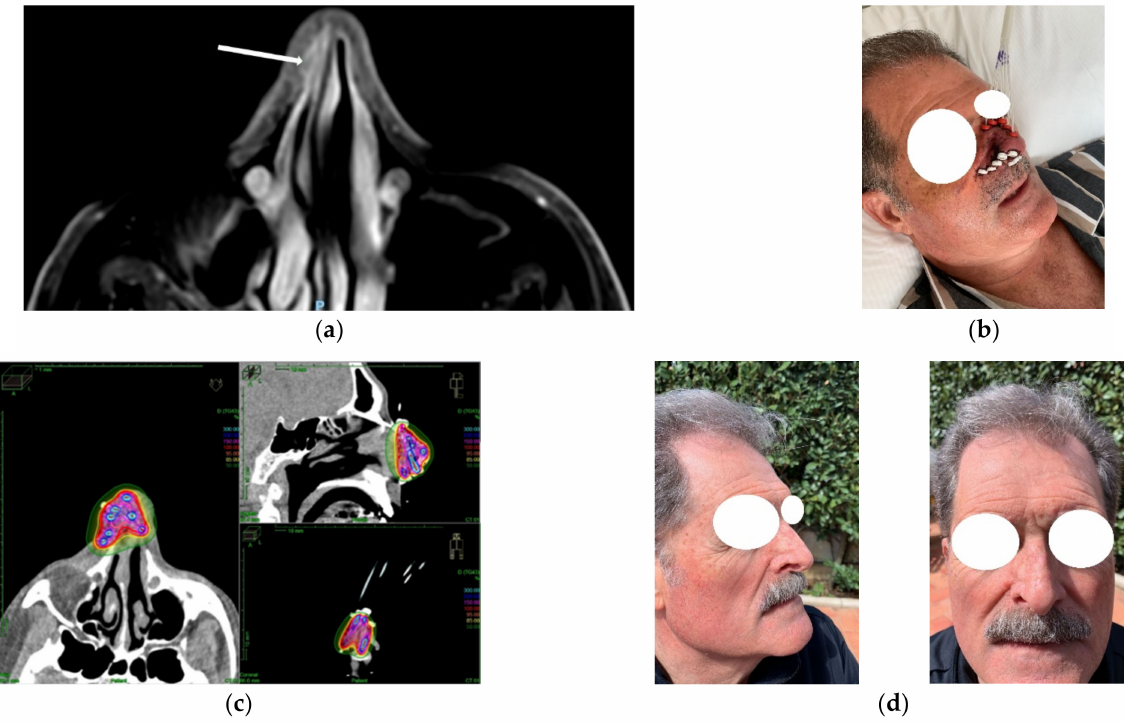
Figure 3. ( a ) MRI with initial diagnosis. ( b ) Implant with plastic tubes and buttons sutured to the skin. ( c ) Treatment plan with isodoses. ( d ) Cosmetic outcome 1 year after IRT. The arrow indicates the primary lesion of the nose